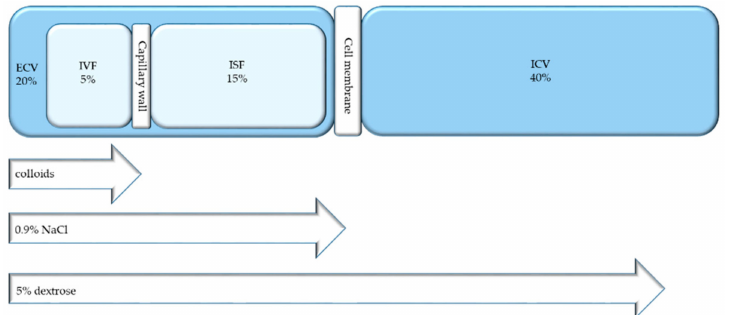
Figure 7. Infused fluids across the body compartments. ECV: Extracellular volume, ICV: Intracellular volume, IVF: Intravascular fluids, ISF: Interstitial fluids, NaCl: Sodium